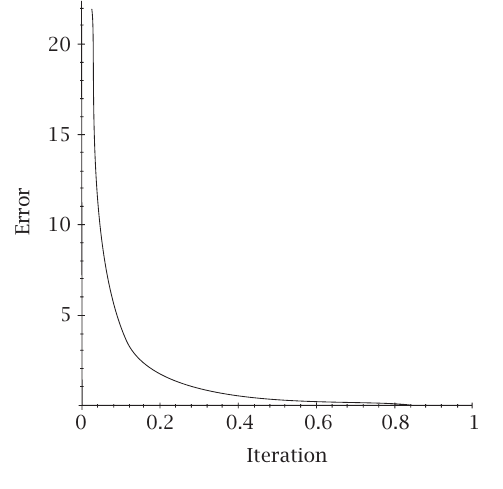
Figure 4.2 . Proposed error function of backpropagation